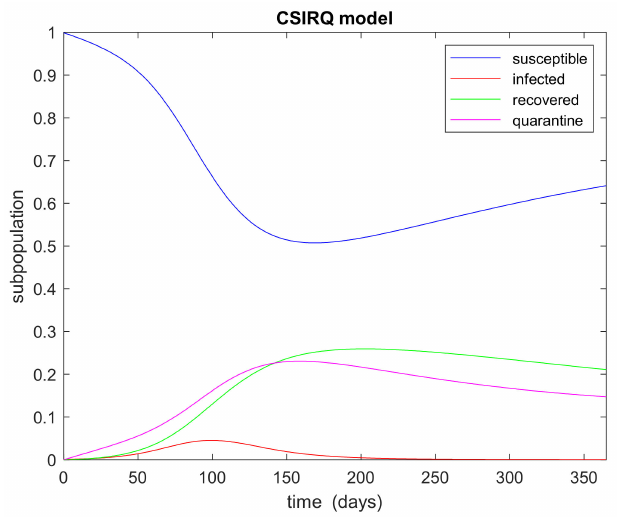
Figure 11. Typical dynamics of the CSIRQ model for the following constant rates ( α = 0.18, β = 0.06, γ = 0.006, δ = 0.001, µ = 0.0001, ζ = 0.06, ι = 0.006, Cumulative viral load = 4.32 (for t = 365 days)).